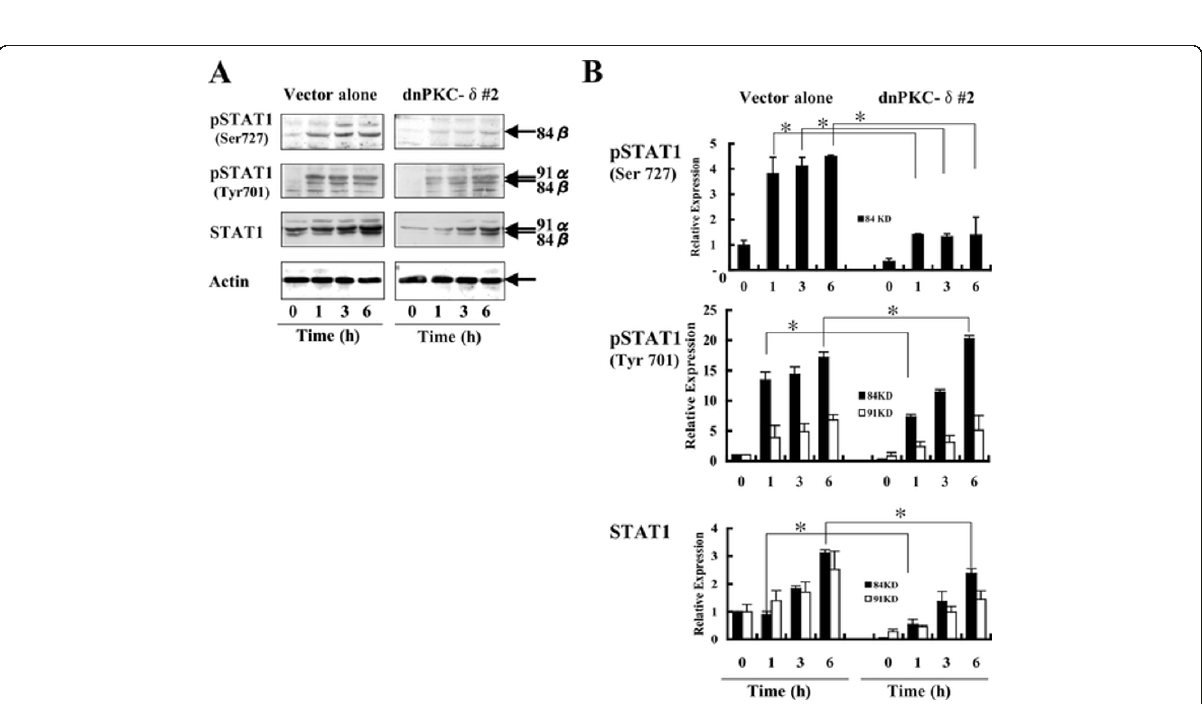
Figure 6 IFN- a -induced Ser727 phosphorylation of Stat1 is substantially abrogated in the dnPKC- δ -overexpressing cells . The cells overexpressing dnPKC- δ or the control vector alone were stimulated with 1,000 U/ml for the indicated time periods, followed by assays for Ser727 and Tyr701 phosphorylation of Stat1 using Abs specific for phospho-Ser727 and phospho-Tyr701, respectively (A). Results are expressed as relative expression (B), as shown in Figure 2. *Significantly different ( p < 0.05) from control vector